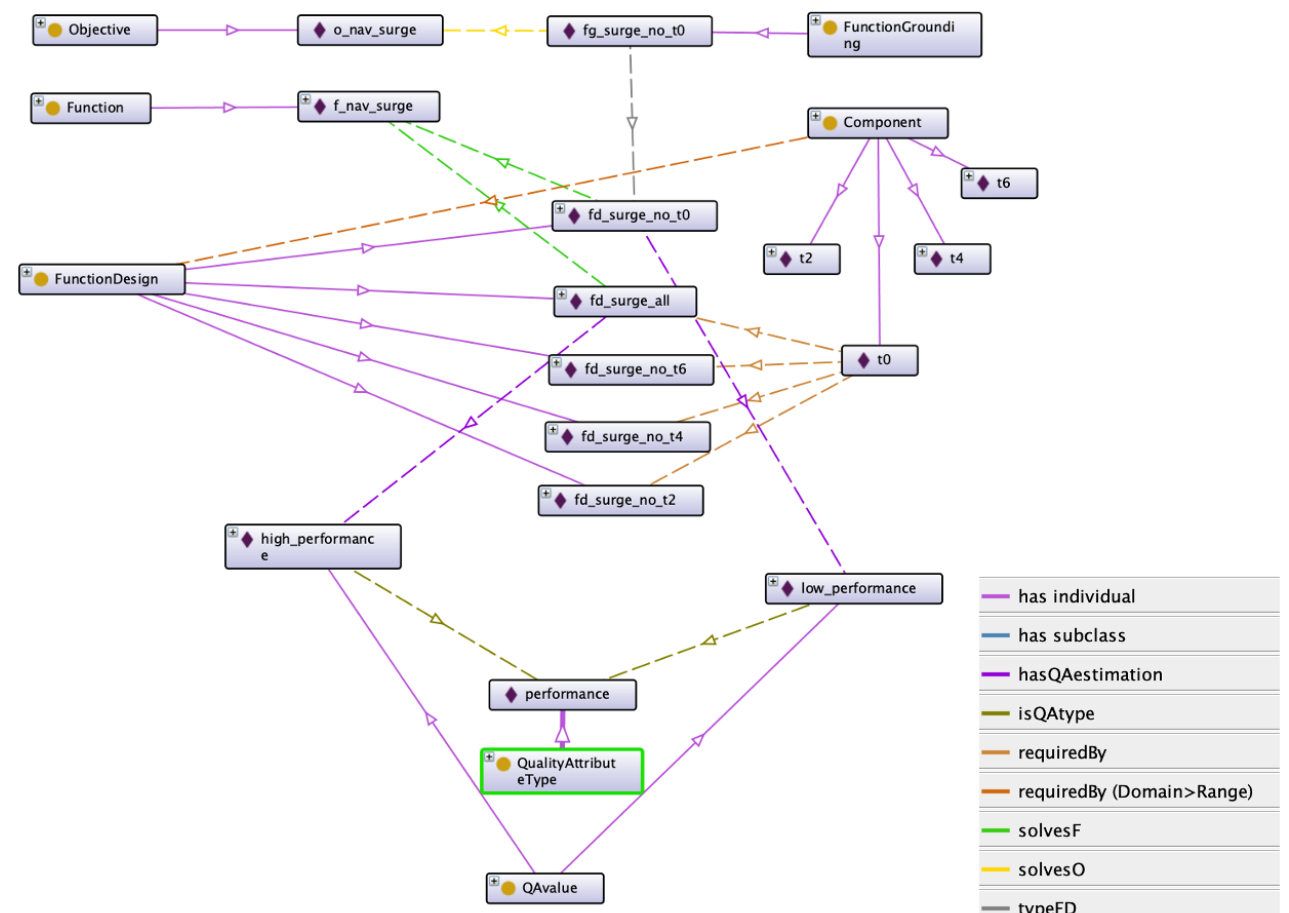
Figure 7. Main relationships affected by thruster T 0 contingency. The metacontroller uses the information in the knowledge- base partially represented here to take action. The Objective o_nav_surge is fulfilled by the Function Grounding fg_surge_no_t 0 , this Function Grounding is a realization of the Function Design fd_surge_no_t 0 which solves the Function f_nav_surge . This Function is required as is the one that solves the Objective. Components required to surge are thrusters T 0 , T 2 , T 4 and T 6 . Among all the possible Functions Designs, the one that does not require the broken thruster, T 0 , is the Function Grounding in use, fg_surge_no_t 0 . Additionally, Quality Attributes relative to performance are assigned to each Function Design to prioritize the use of higher performance